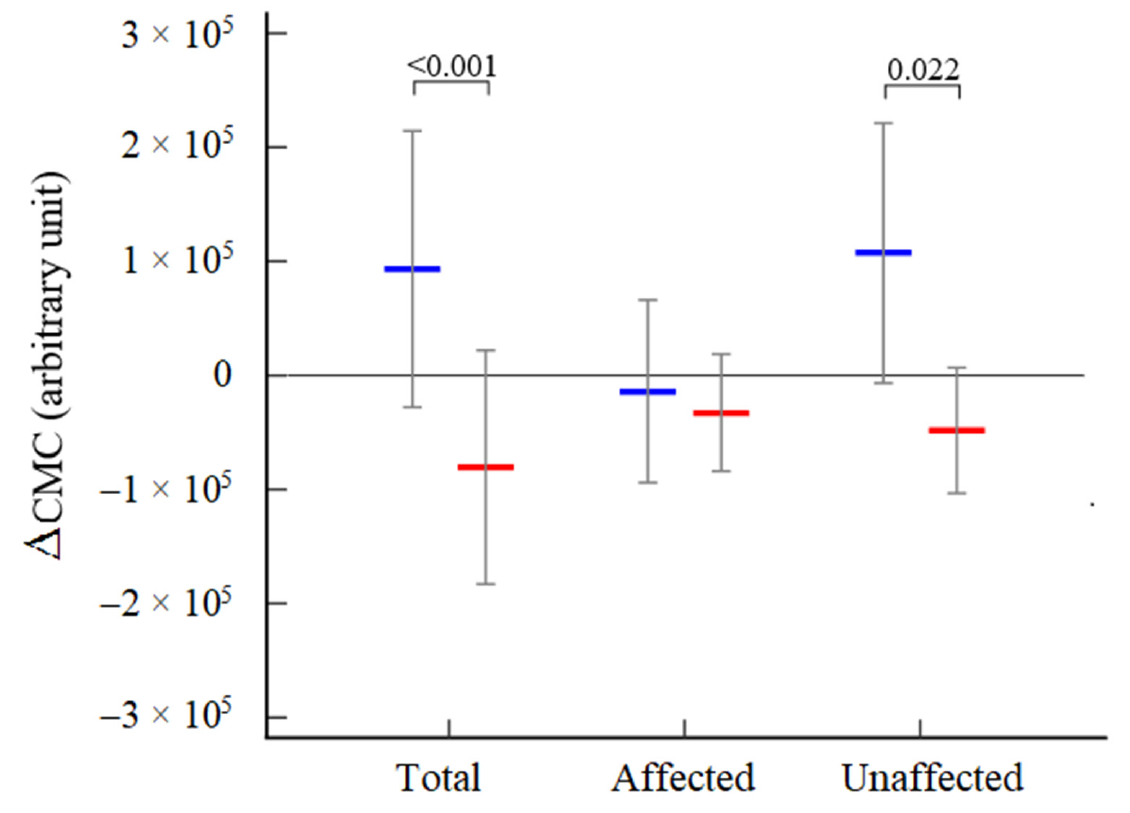
Figure 4. Variations in CMC for the total and both affected and unaffected hemispheres according to access to rehabilitation. Legend: Early (<30 days) blue line; Late (>30 days) red line.